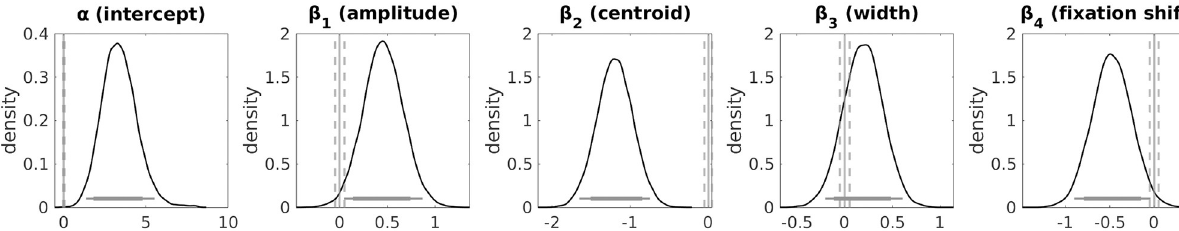
Fig 7. Hierarchical Bayesian regression results. Regression of the parameters of the Gaussian-modelled grip force response and number of fixation shifts onto the subjective value differences (DDM). Posterior distributions of the group-level parameter means. α : intercept, β 1: coefficient for grip force amplitude, β 2 : coefficient for grip force centroid, β 3 : coefficient for grip force width, β 4 : coefficient for fixation shift. Horizontal solid lines indicate the 85% and 95% highest density interval. Vertical solid lines indicate x = 0, and vertical dashed lines indicate the lower and upper bounds of the region of practical equivalence